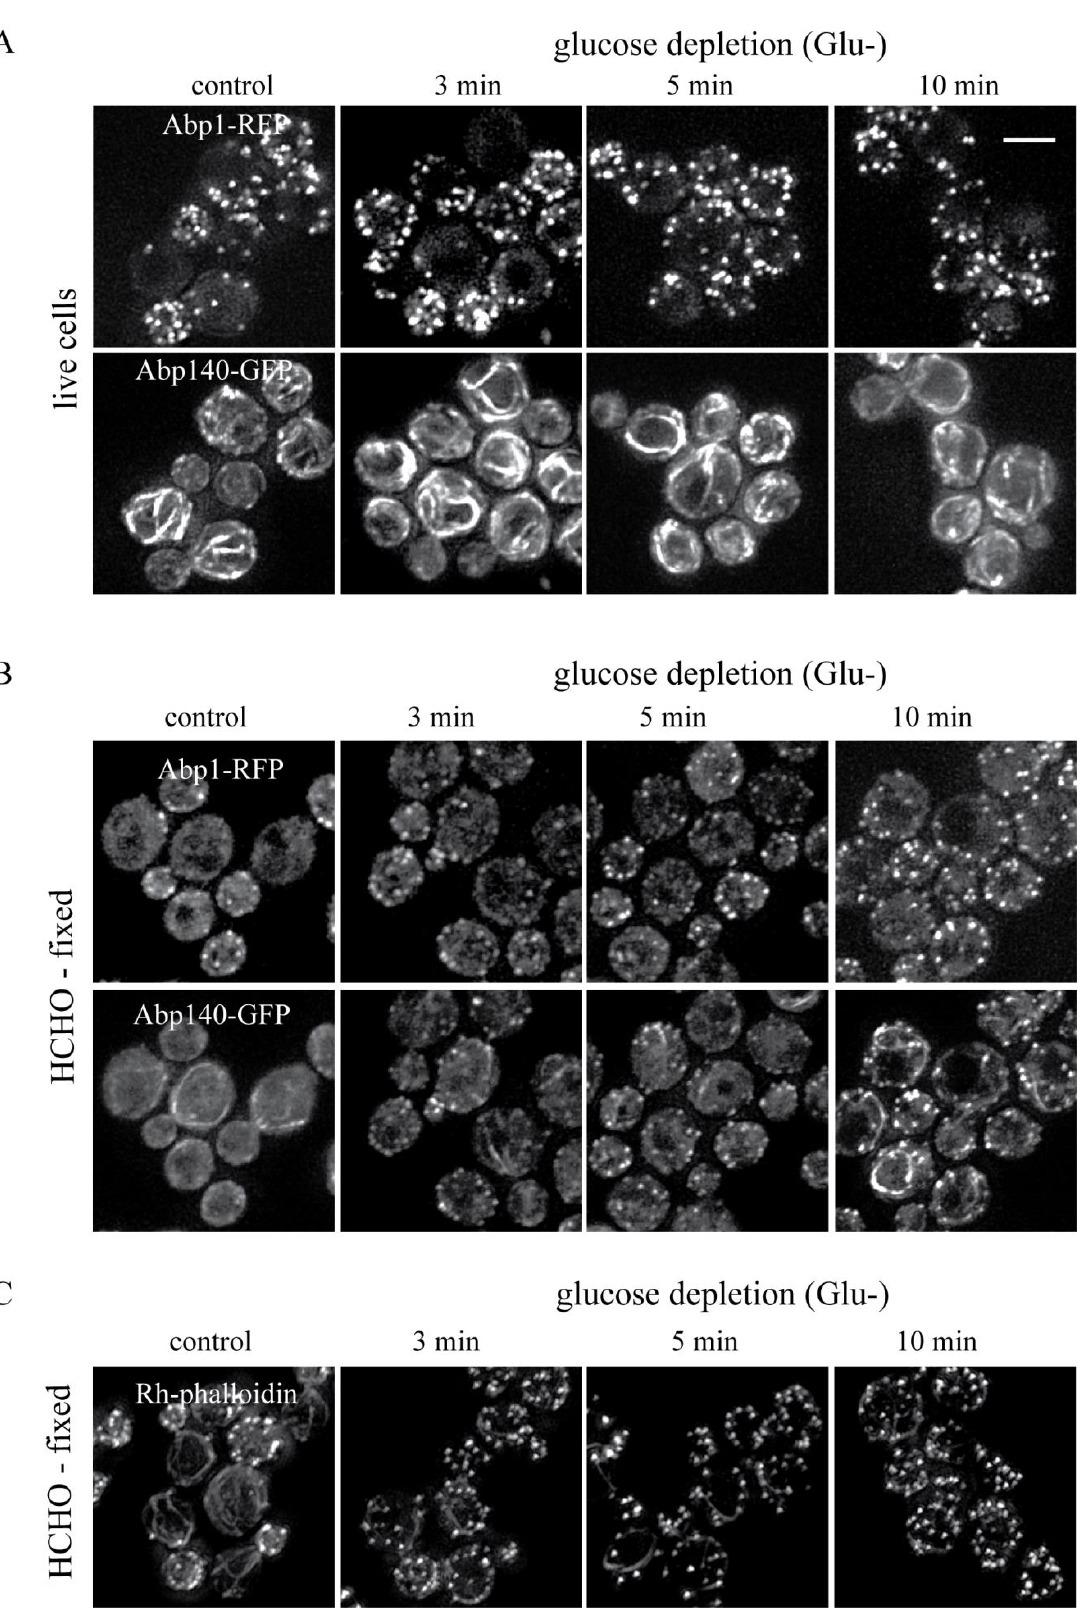
FIGURE 3: The effect of glucose deprivation on F-actin distribution was analyzed at defined time points after the shift of cells into glucose- free medium. Z-stacks of S. cerevisiae (rho + ) cells co-expressing Abp1-RFP and Abp140-GFP from chromosomal sites (strain CRY1337) in- spected as live cells (A) or after fixation with 3.7 % formaldehyde for 30 minutes (B) (HCHO-fixed). (C) The Z-stack of formaldehyde-fixed S. cerevisiae (rho + ) cells (strain CRY339) stained with Rh-phalloidin for F-actin. Bar, 5